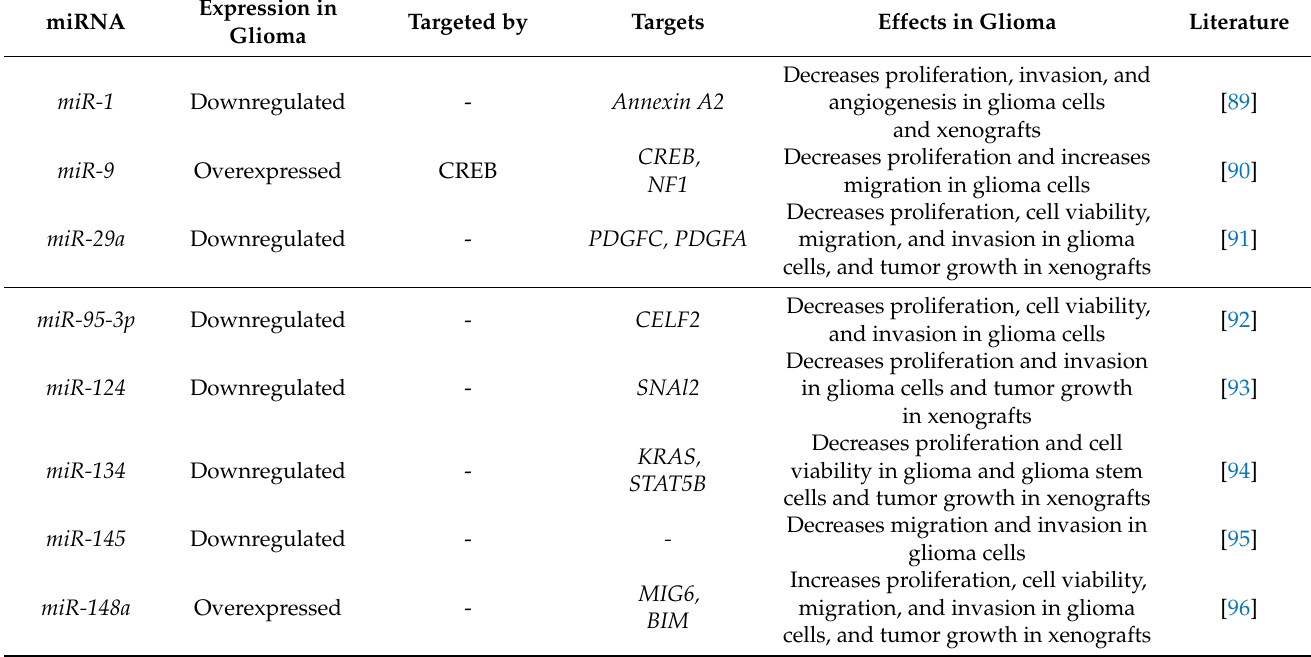
Table 2. Dysregulated miRNAs in glioma